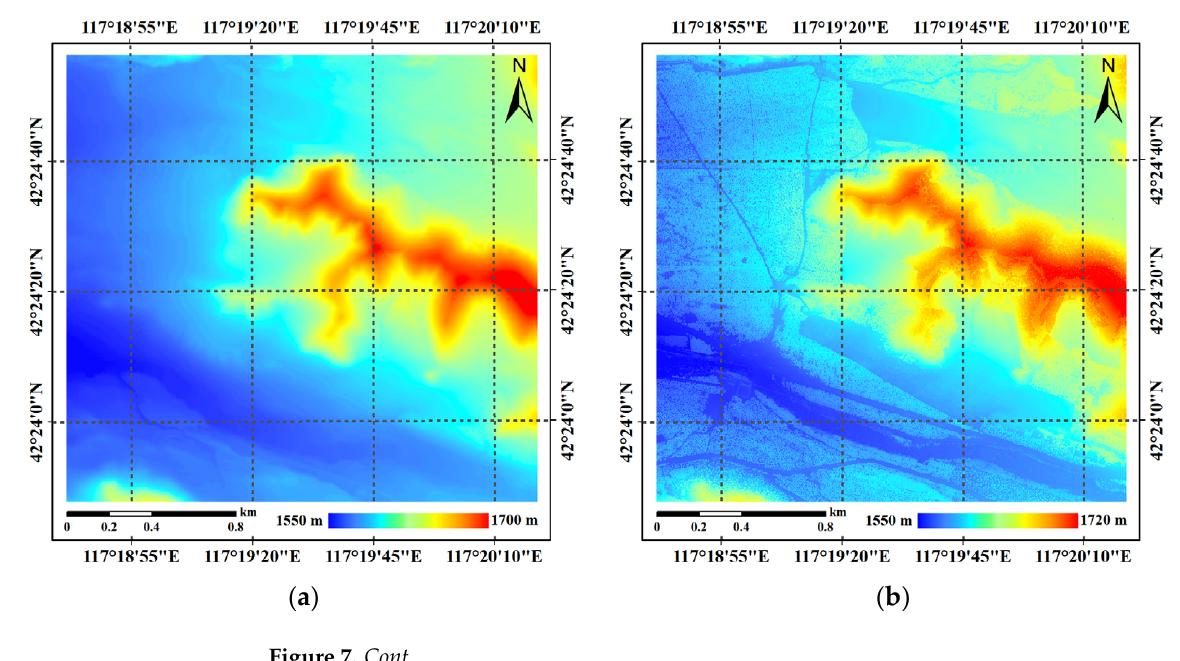
Figure 6. The primary images of P-band and X-band InSAR: ( a ) Pauli RGB display of the P-band primary image; ( b ) Intensity display of X-band primary image.